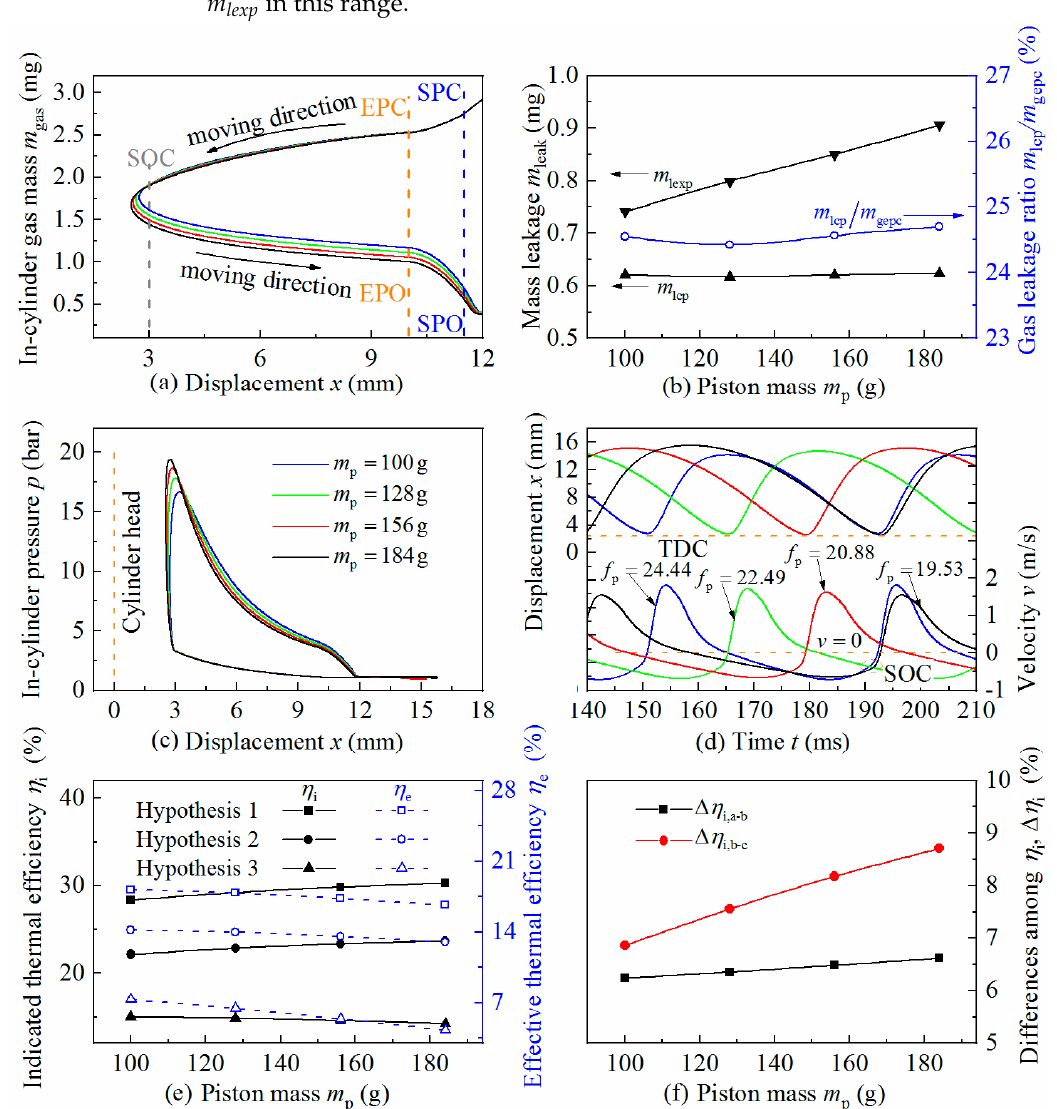
Figure 10. The influence of piston mass on leakage and system performance. ( a ) Mass variations of in-cylinder gas in function of stroke; ( b ) Mass leakage; ( c ) Pressure variations of in-cylinder gas in function of stroke; ( d ) Piston dynamic characeristics; ( e ) Thermal efficiencies; ( f ) Indicated thermal efficiency drops. Figure ( a , c , d ) apply the same legend displayed in figure ( c ). The blue, green, red and black solid lines stand for the piston mass of 100, 128, 156 and 184 mm, respectively. The symbol f p in figure ( d ) stands for piston frequency, Hz.